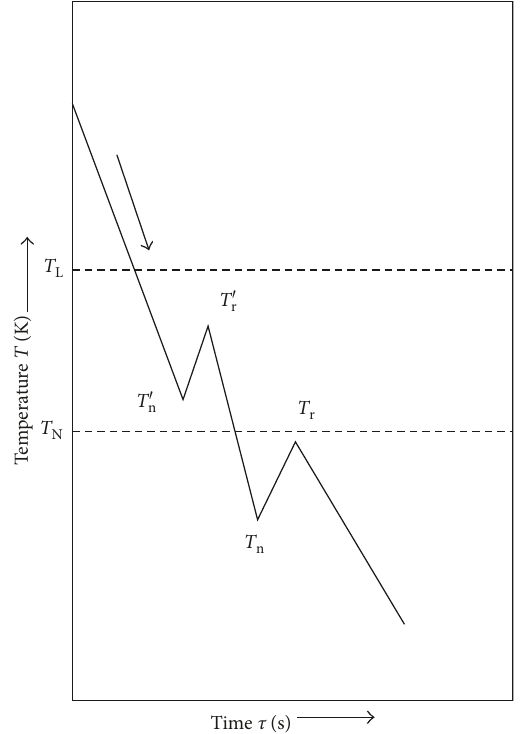
Figure 2: Cooling curves of the undercooled Cu-40 wt.% Pb alloy melt ( T L is liquidus and T N is monotectic reaction